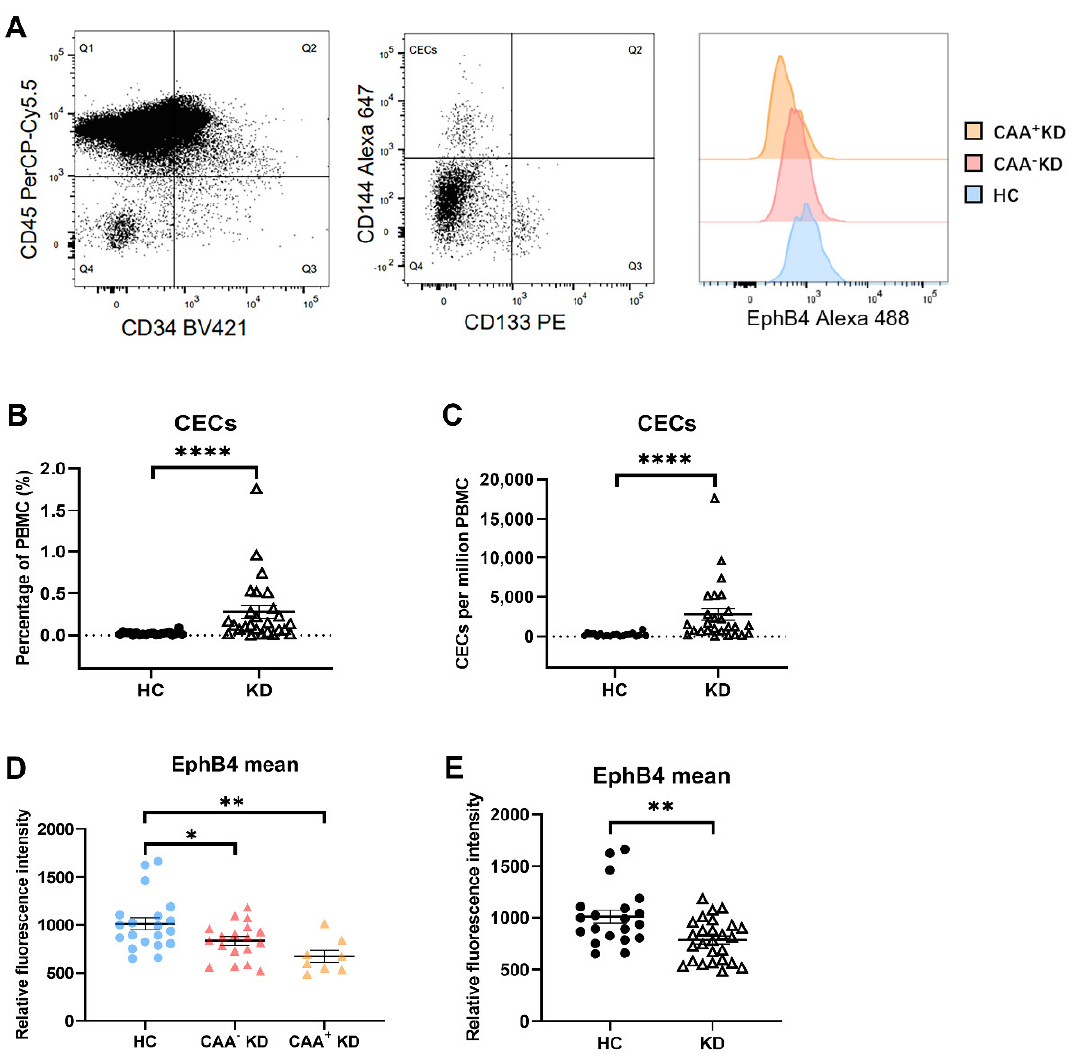
Figure 1. The expression of EphB4 was compared in KD patients and HCs. ( A ) Flow cytometric detection of CECs. The analysis gate (Q3) included CD34+ CD45- cells. The expression of CD133 and CD144 in the Q3 gate was detected. CECs were defined as CD34+CD45-CD133- and CD144+. The expression of EphB4 in CECs was detected. ( B ) Percentage level of CECs in PBMC was analyzed by FlowJo. ( C ) Numbers of CECs per million PBMC were compared between HCs and KD patients. ( D ) The mean fluorescent intensity of EphB4 in CECs of HCs, CAA- KD, and CAA+ KD was assayed. ( E ) The mean fluorescent intensity of EphB4 in CECs of HCs and KD patients was compared. The bar graphs are the mean ± SEM. * p < 0.05, ** p < 0.01, **** p < 0.0001 compared with the respective control